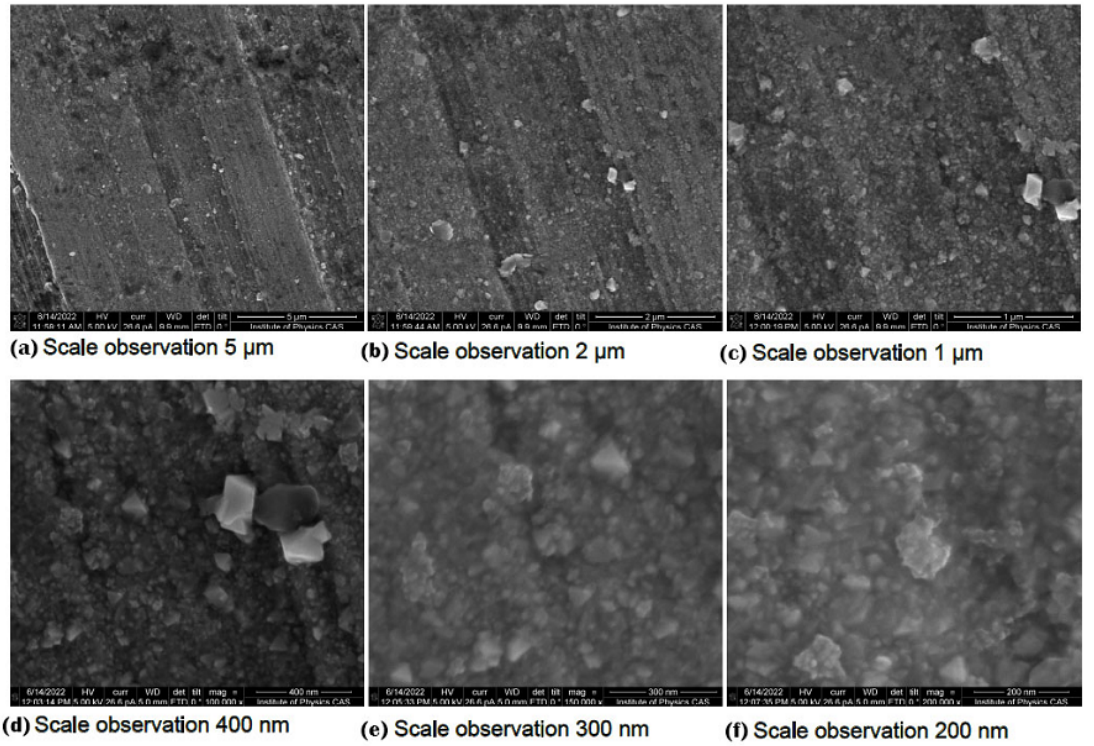
Figure 14. FEG-SEM images of surface layer oxide crystals of LSP-treated specimen, images ( a – f ) at gradually increasing